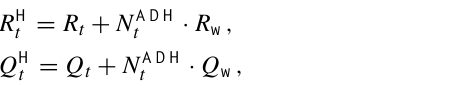
where subscript w stands for the reference solvent